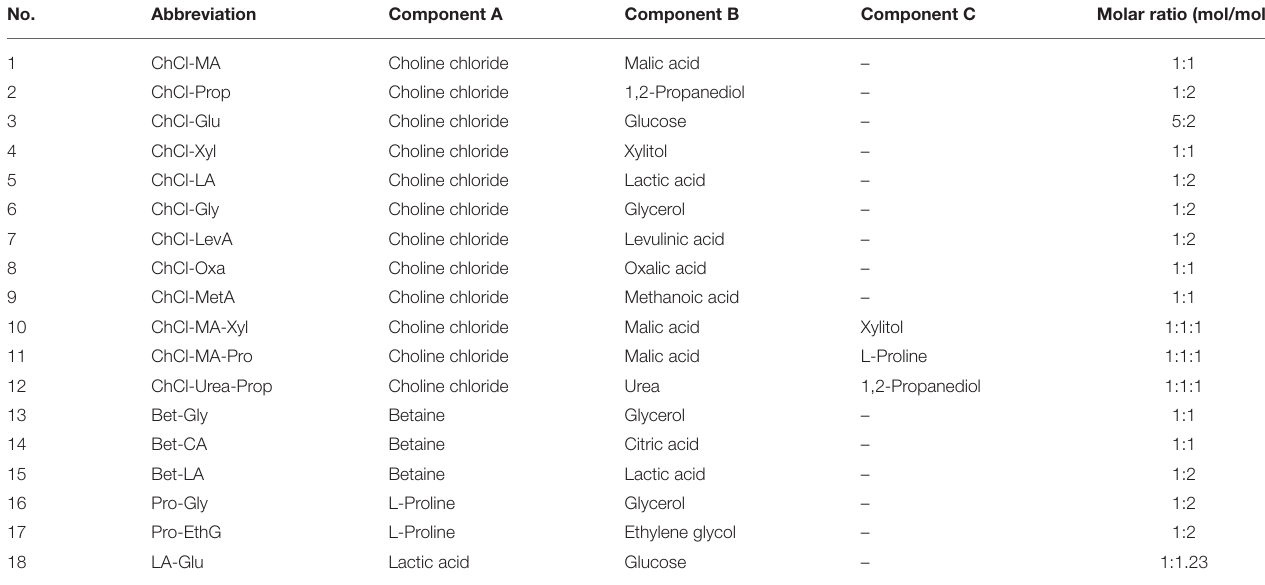
TABLE 1 | List of DESs prepared in this study.